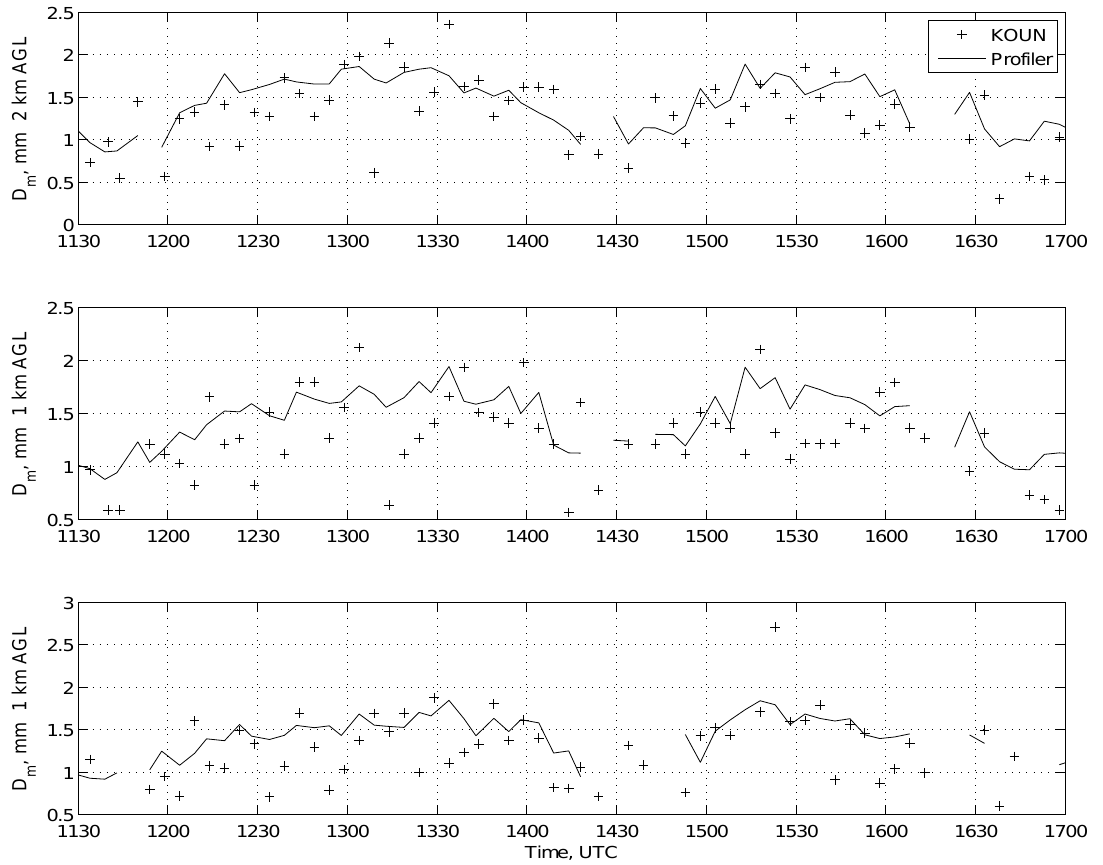
Fig. 8. Time history plots of D m for an exponential DSD retrieved from KOUN during 13 July 2007 rain event at 3km a.g.l. (upper panel),